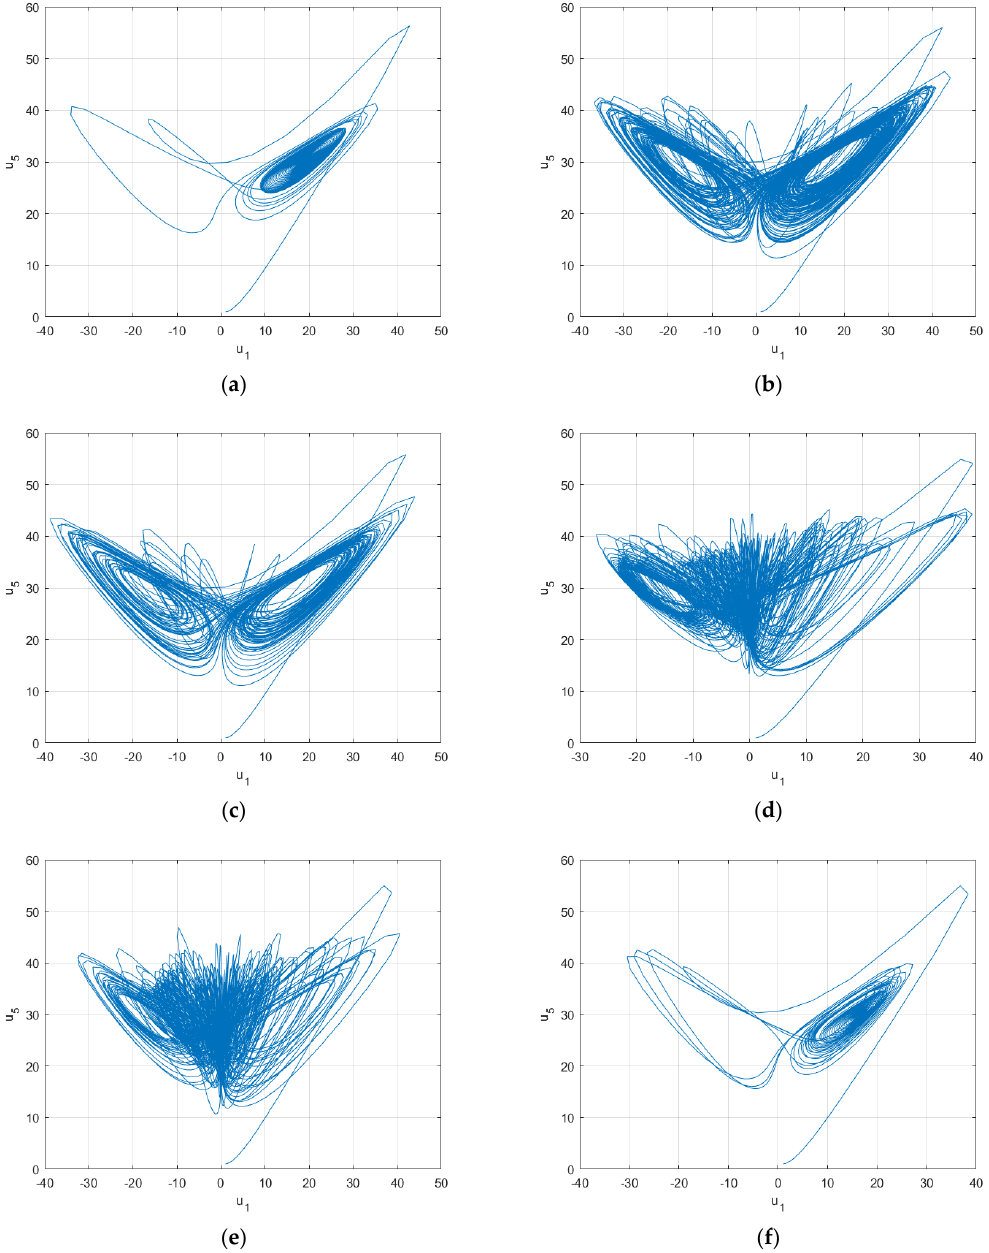
Figure 11. The evolution process of system (11) with parameter d . ( a ) d = 6, limit cycle; ( b ) d = 9, chaos; ( c ) d = 10, chaos; ( d ) d = 60, chaos; ( e ) d = 100, chaos; ( f ) d = 151.6, limit